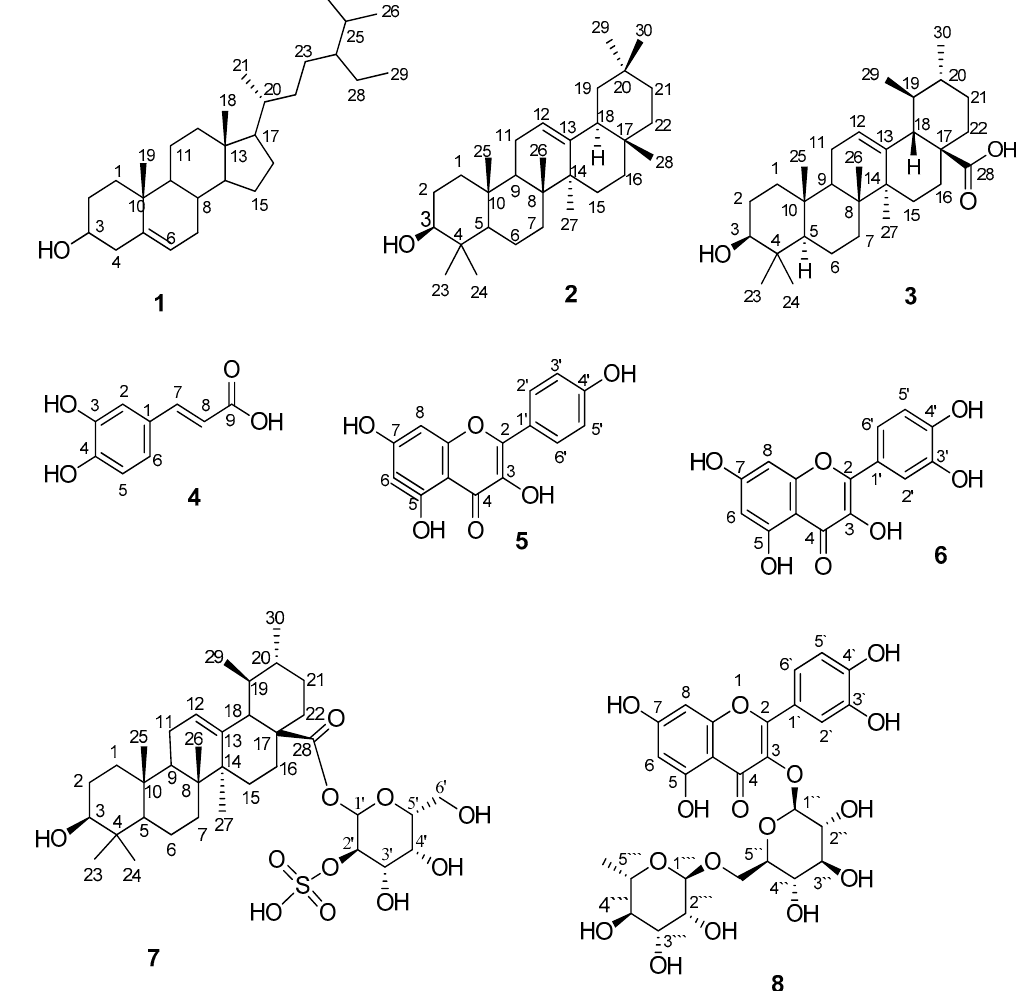
Figure 1. Chemical structures of the isolated